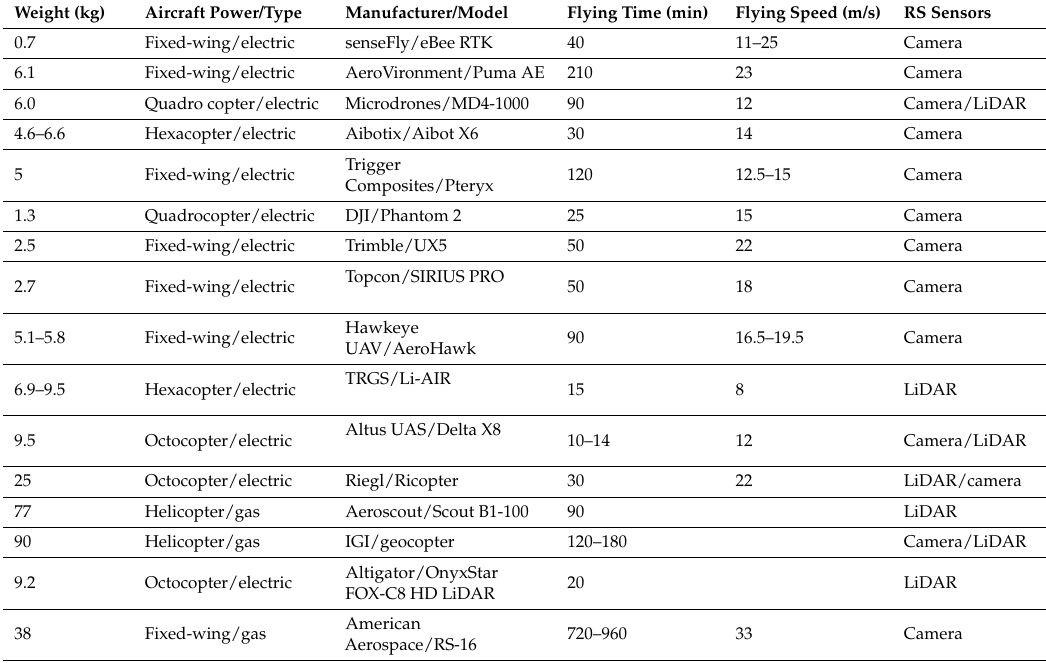
Table 7. UAV platforms for